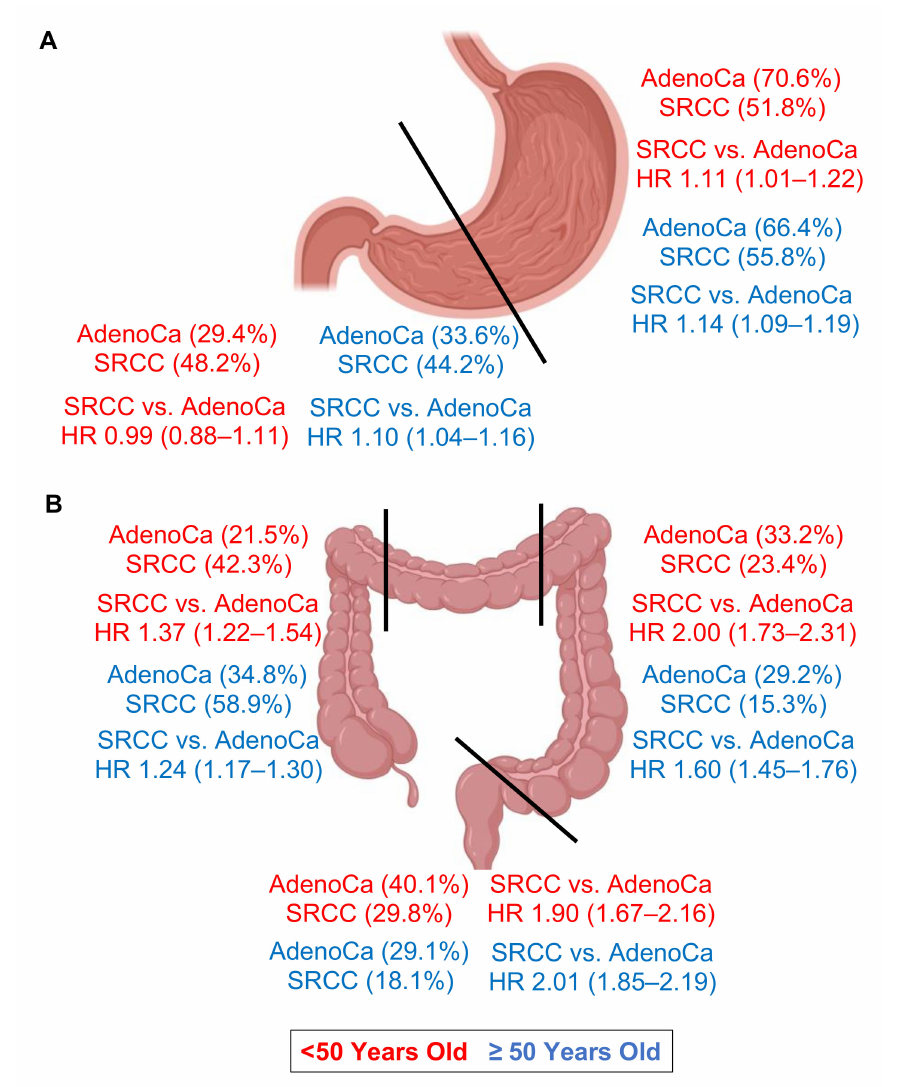
Figure 3. Graphical summary of key findings. ( A ) Percent distribution and hazard ratio comparing adenocarcinomas to signet ring cell adenocarcinomas in the proximal and distal stomach by age. ( B ) Percent distribution and hazard ratio comparing adenocarcinomas to signet ring cell adenocarci- nomas in the right colon, left colon, and rectum by age. Red indicates values for patients < 50 years old, and blue for patients ≥ 50 years old. Hazard ratios display 95% confidence intervals. AdenoCa, adenocarcinoma; SRCC, signet ring cell adenocarcinoma; HR, hazard